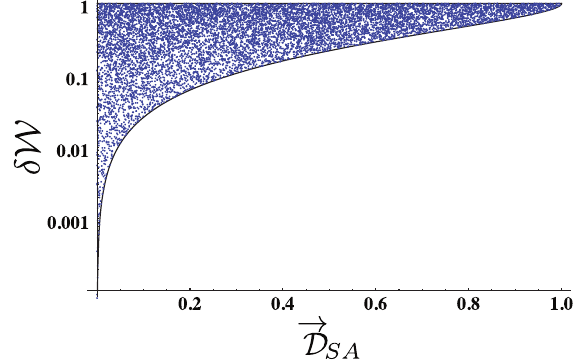
Fig. 2 Distribution of two-qubit states in the daemonic gain-vs.- discord plane. We have generated 3 × 10 3 general random states of system and ancilla, evaluating the discord and daemonic gain for each of them ( blue dots ). The blue curves enclosing the distribution correspond to the boundaries discussed in the body of the paper. Notice that states with no quantum correlations may correspond to arbitrarily large values of the daemonic gain δ